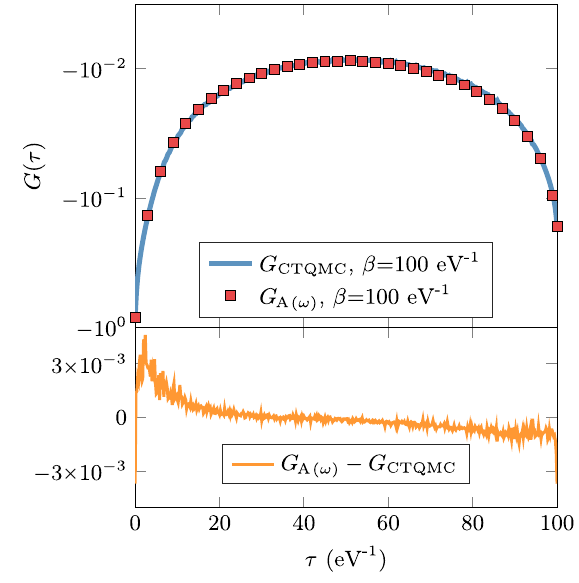
FIG. 10. Comparison of imaginary-time Green ’ s functions G ð τ Þ from CTQMC (G , blue line) and FTPS using Eq. (15) CTQMC (G , red squares). As in Fig. 6, they compare very A ð ω Þ